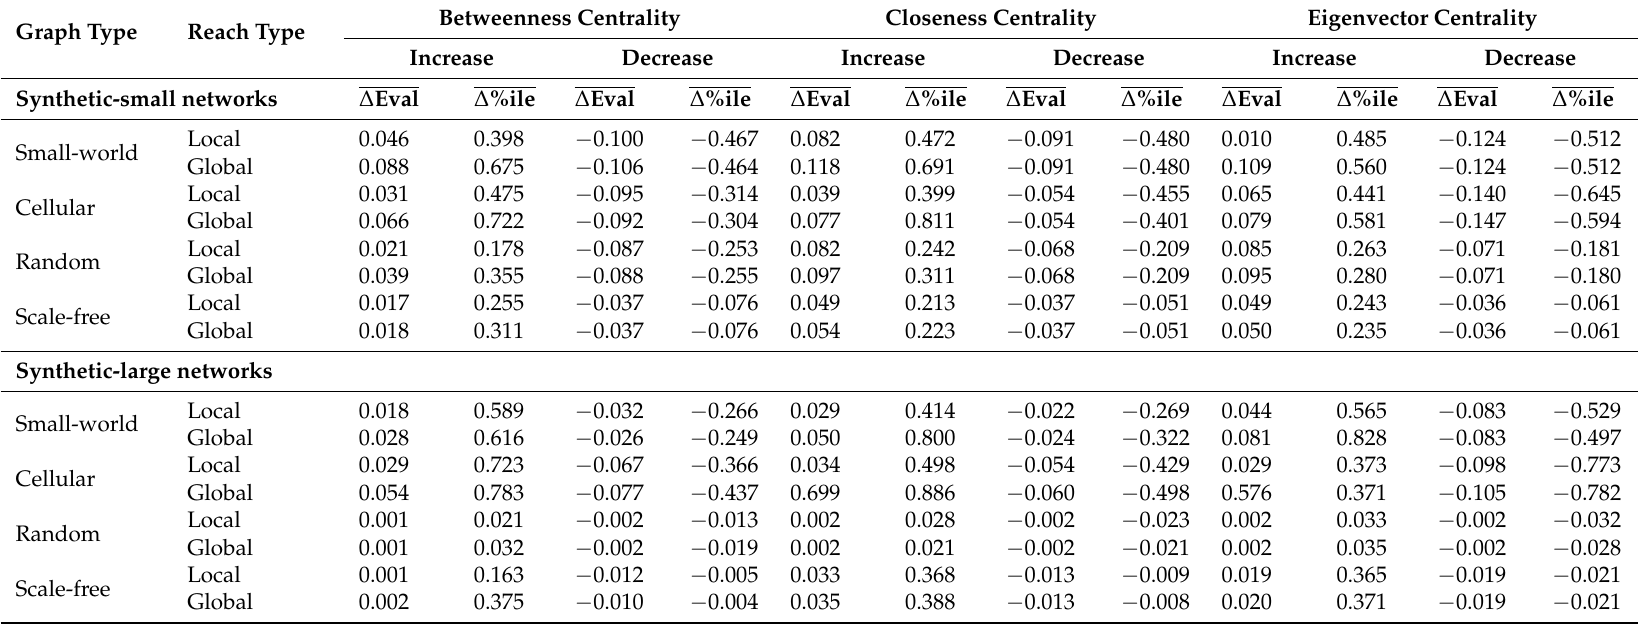
Table 4. Evaluation and percentile difference across synthetic network results. ∆ Eval is the mean difference in centrality measure before and after an attack; ∆ %ile is the mean difference in target node centrality ranks (percentiles) before and after an